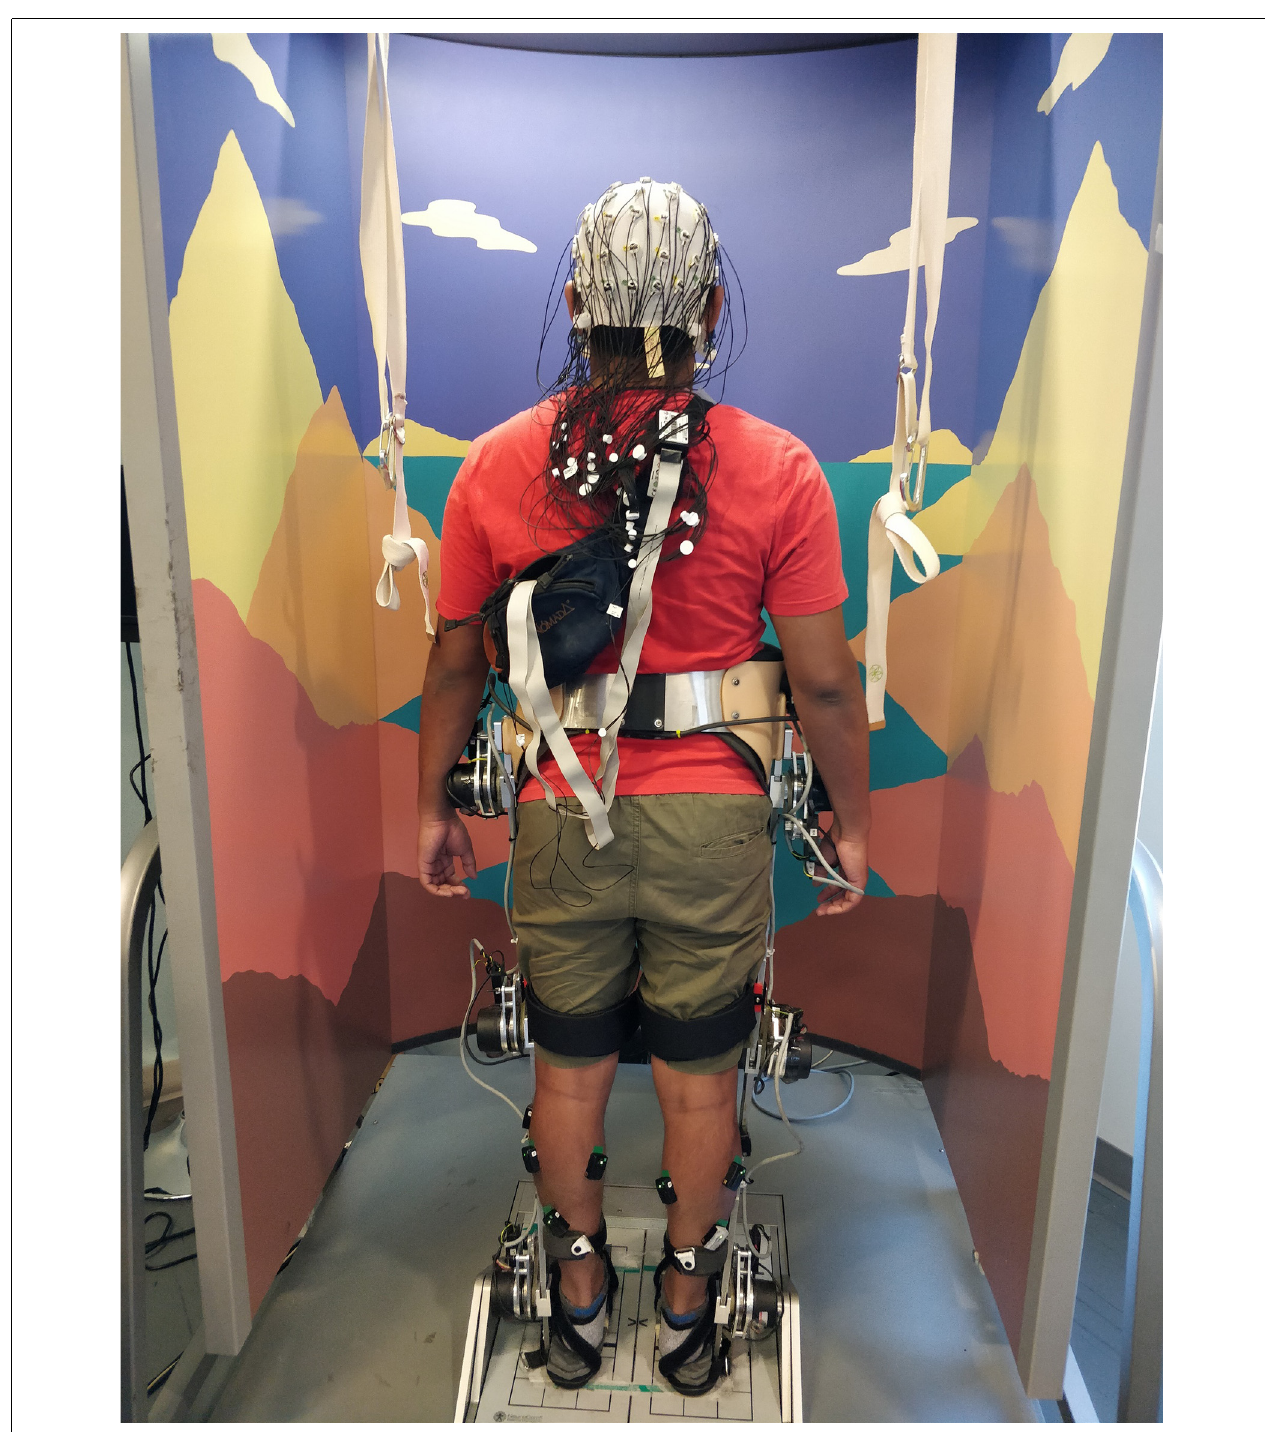
FIGURE 1 | A fully instrumented participant prepared for data collection with and without wearing the H2 exoskeleton while standing on the Neurocom Balance Master. Note the foot pads on H2. During data collection, the participant was secured in a harness to prevent falling.